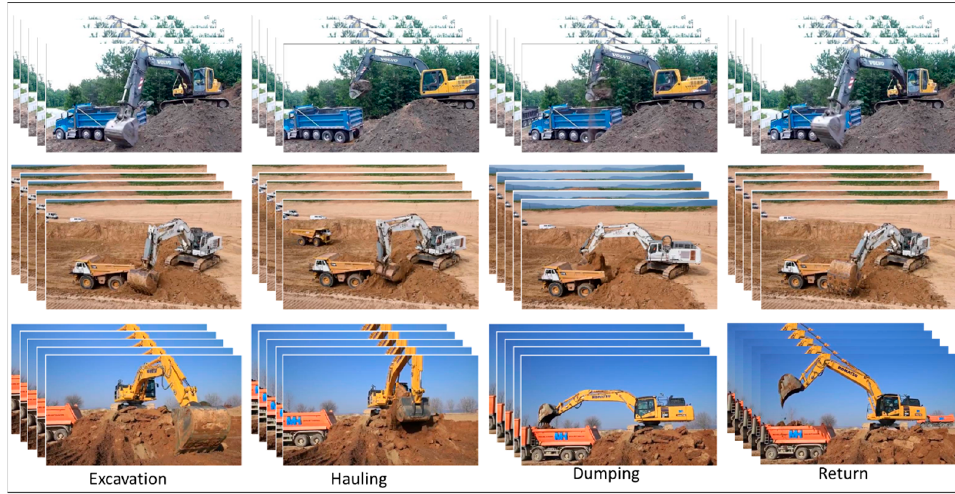
Figure 1. Activities of an excavator operation.